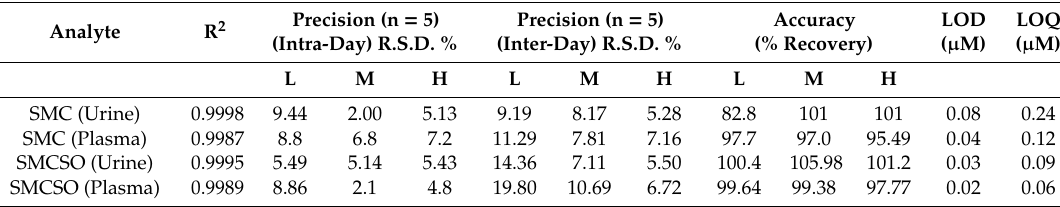
Table 2. Validation data in human plasma and